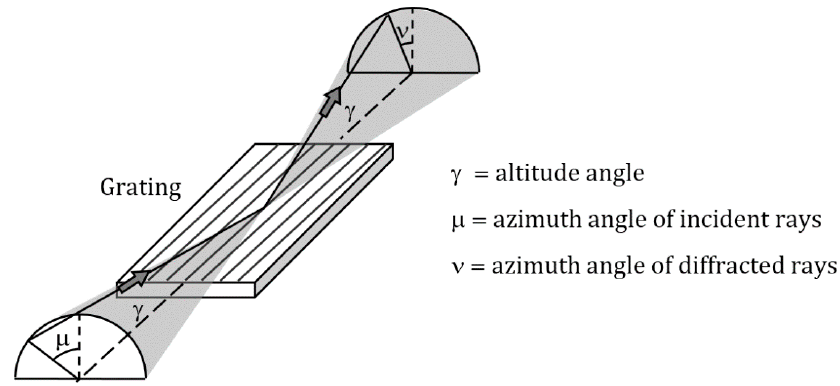
Figure 1. Off-plane mount (OPM) geometry.